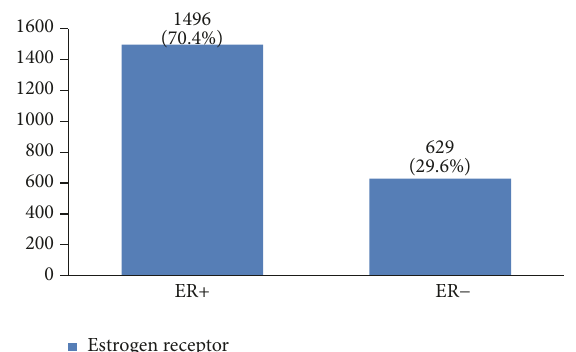
Figure 29: The distribution of P53 in the studied cases.